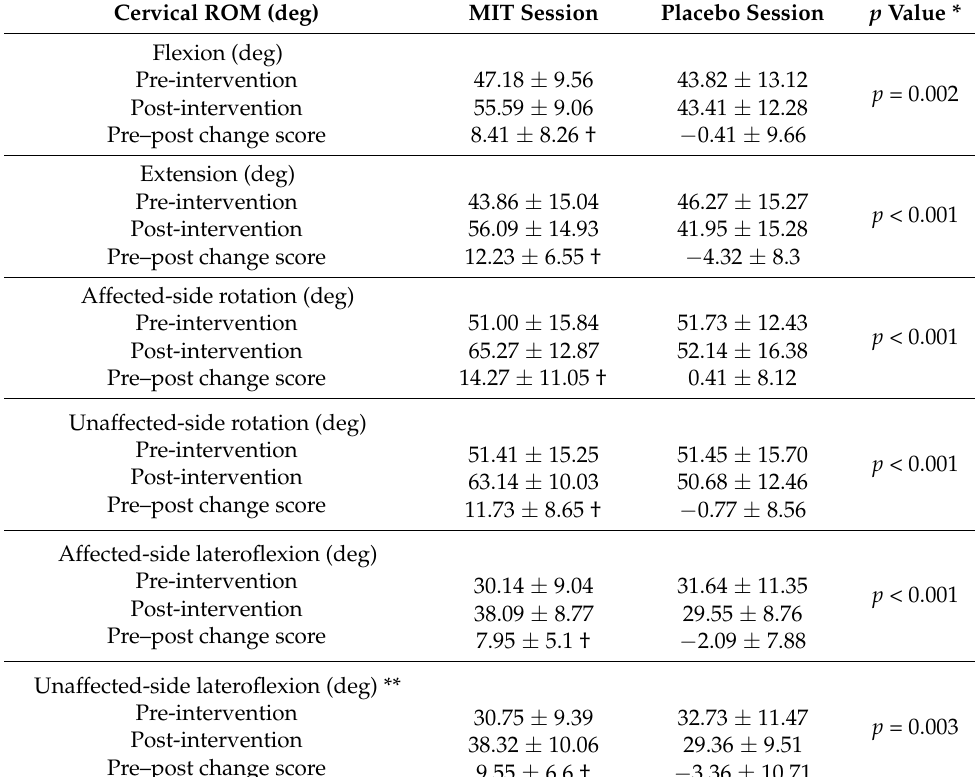
Table 3. Pre-intervention, post-intervention, and change scores for cervical ROM ( n =